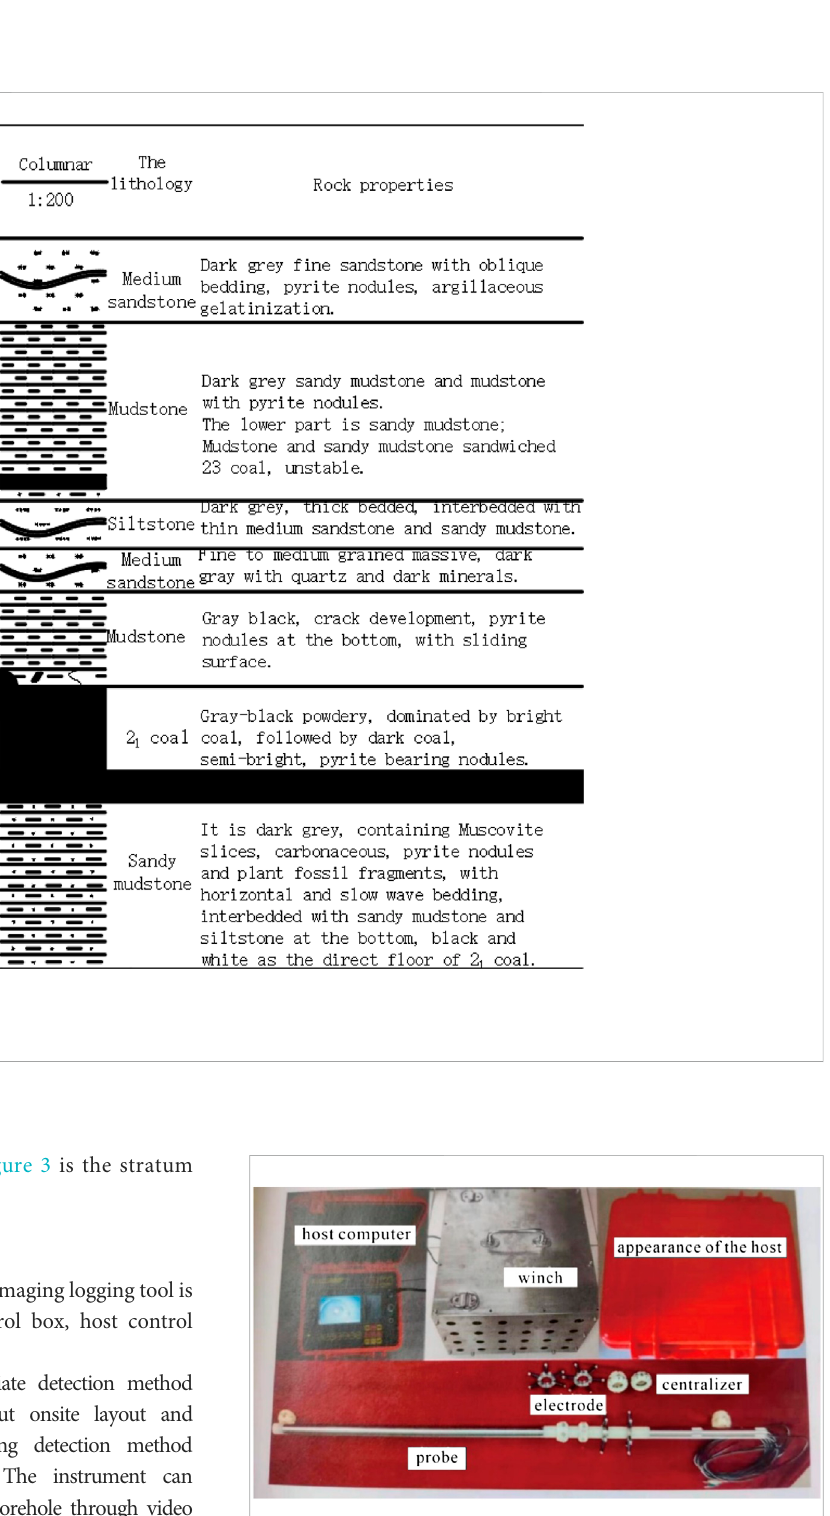
FIGURE 4 YZD18.5 mine lateral resistivity video imaging logging